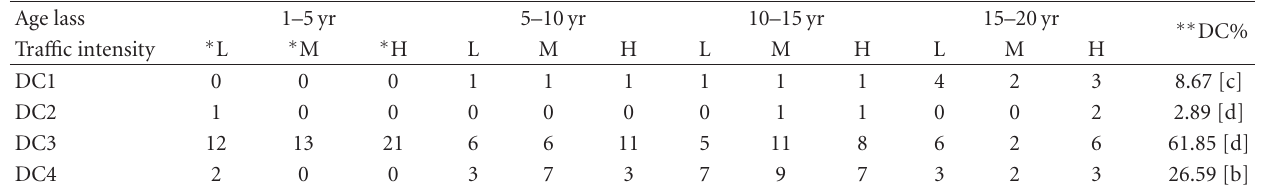
Table 6: Distribution of damaged trees based on severity of damage.